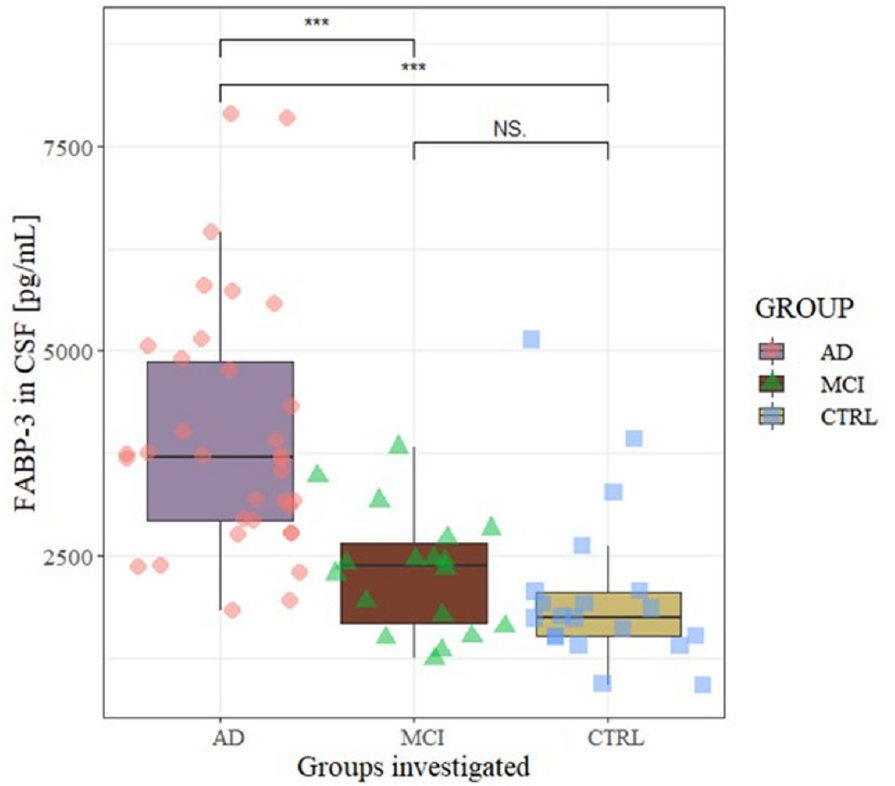
Figure 1. CSF levels of FABP3 in the analyzed groups. Level of statistically significant *** p < 0.001, NS—no significant. AD—Alzheimer’s Disease, MCI—mild cognitive impairment, CTRL—control, CSF—Cerebrospinal fluid.